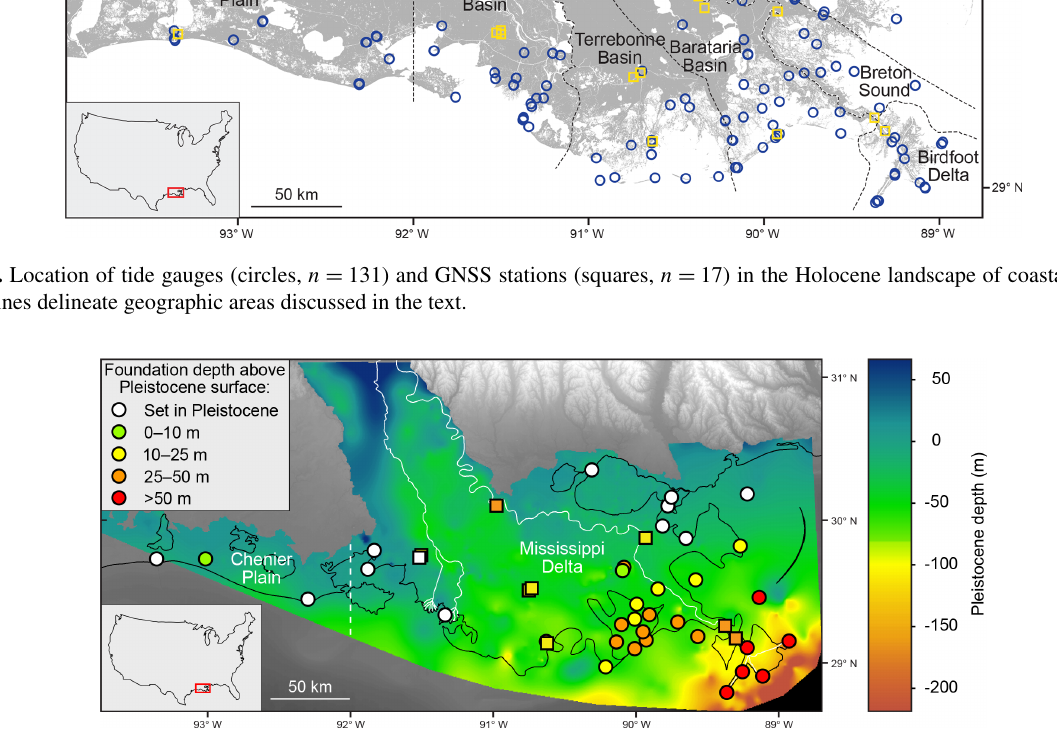
Figure 3. Elevation of the Pleistocene surface in coastal Louisiana (with respect to NAVD 88), which approximates the depth of the Pleis- tocene surface beneath the land surface given land surface elevations close to mean sea level. Circles and squares indicate tide gauge and GNSS station locations, respectively, and are color coded according to foundation height above the Pleistocene surface. Note that two GNSS stations (ENG1 and ENG2; see Table 2) have the same coordinates (and the same foundation depth) and plot on top of one another. The dashed white line, located at longitude 92 ◦ W, divides the Mississippi Delta from the Chenier Plain. Solid white lines show the Mississippi and Atchafalaya rivers. Black lines indicate shorelines. Pleistocene depth information is from Heinrich et al.